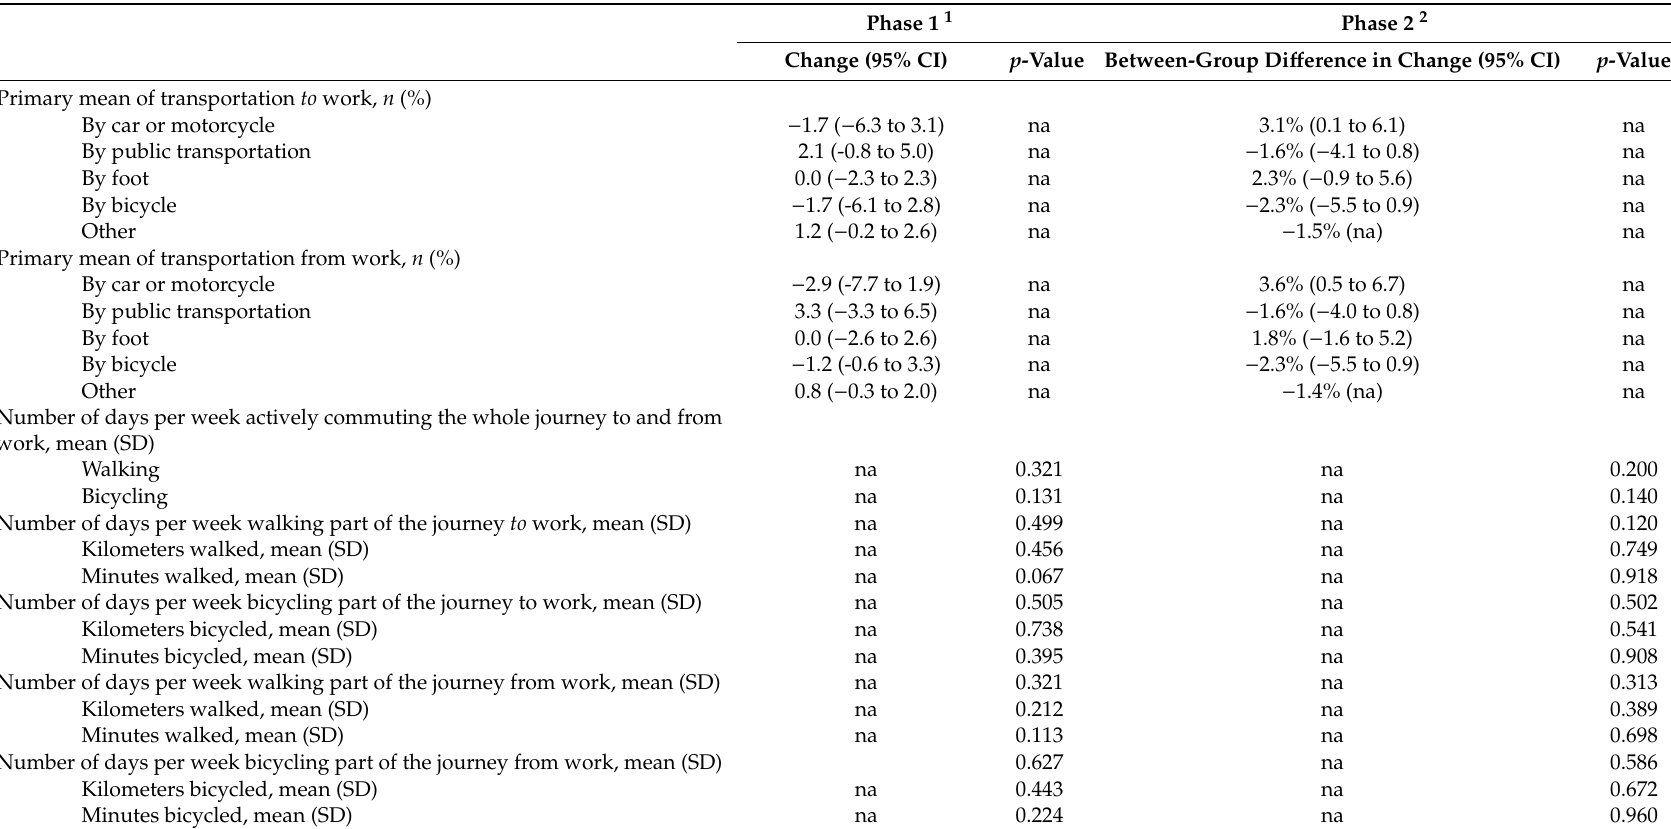
Table 6. Changes in employees’ self-reported ACW in Phase 1 and Phase